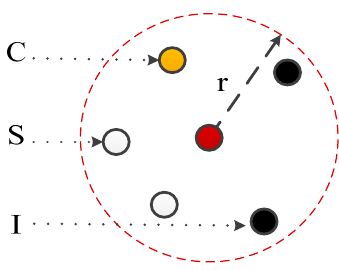
Figure 3. Microscopic view of a sensor individual in propagation.